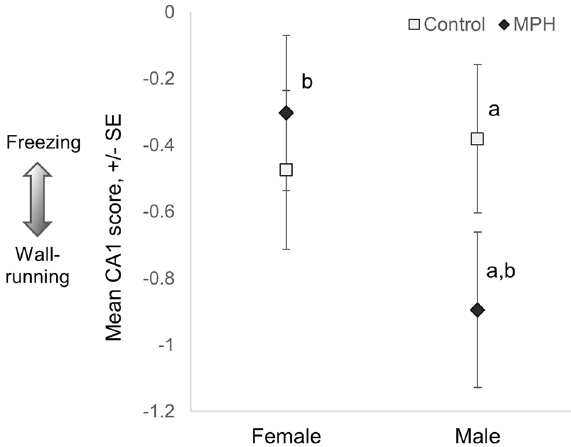
Figure 1. First generation (G 1 ) CA1 scores for the open field test. MPH treated males performed significantly more wall-running than Control males and MPH treated females, and there was a trend for them to perform more wall-running than Control females. Positive CA1 values indicate relatively more freezing and negative values indicate relatively more wall-running. Symbols represent least-square means for each response variable, +/− one standard error. Letters indicate points that are significantly different from one another at P <